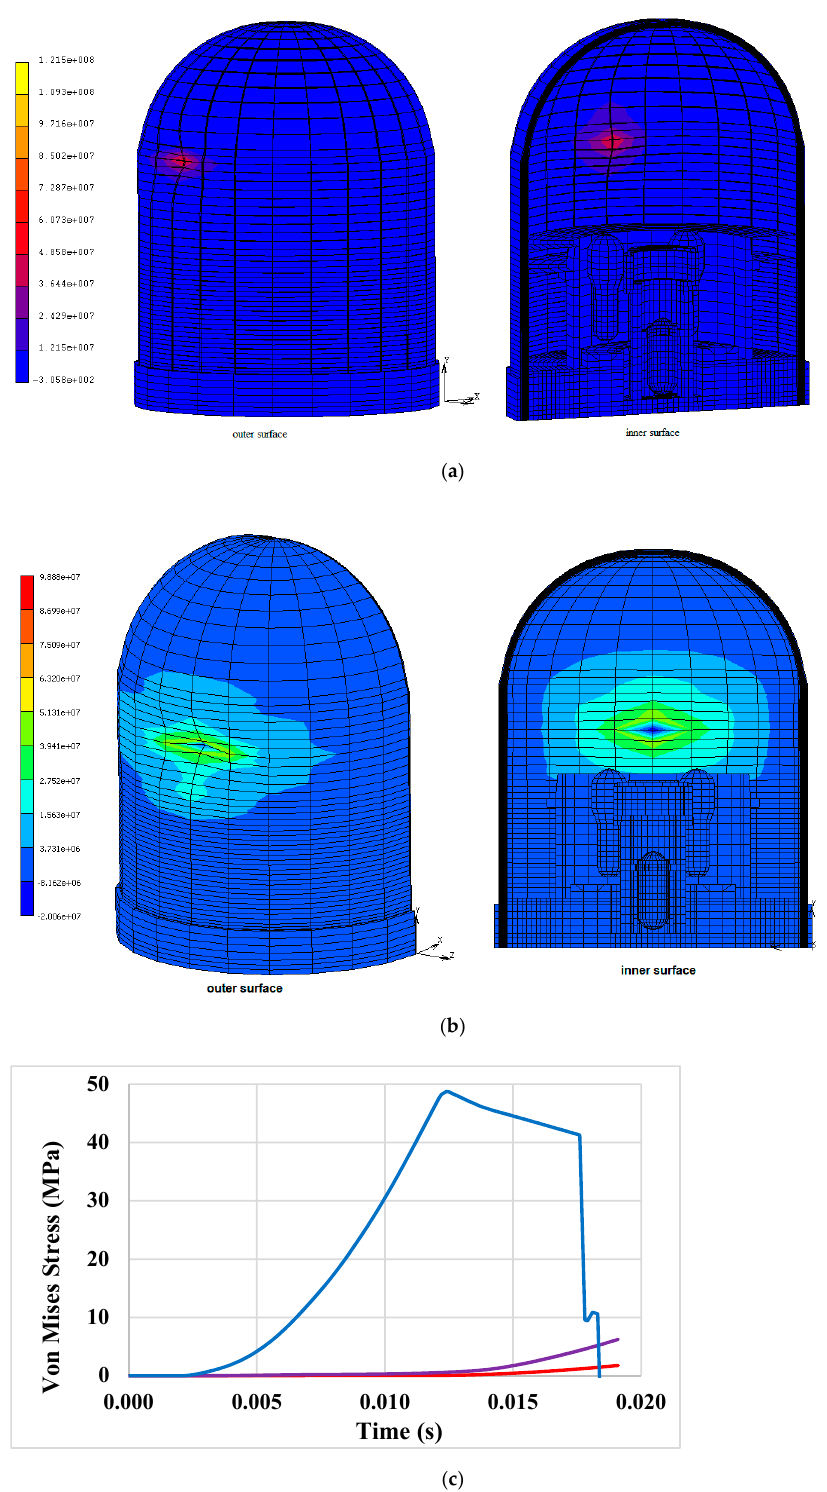
Figure 10. Von Mises stress (Pa) distribution at fuselage crashing for ( a ) unaged and ( b ) aged CC. The figure ( c ) shows the stress trends at several points located inside the aged CC: the blue line represents the behavior at the entry point, the violet the behavior at the reactor cavity pit, and the red curve the behavior at almost the opposite of the entry point.